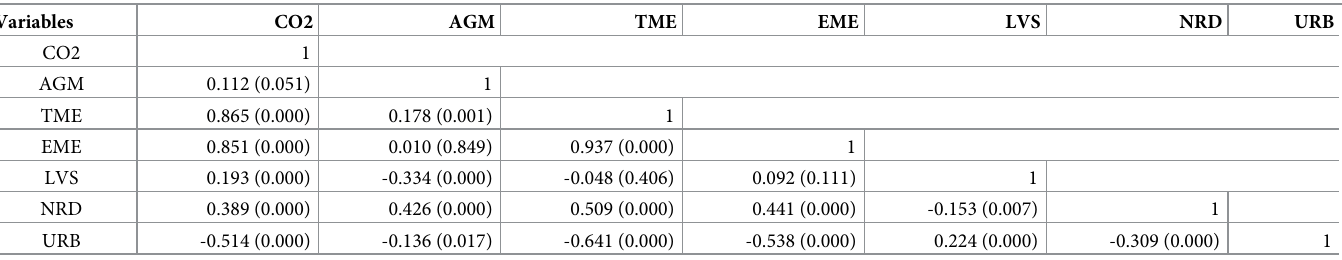
Table 3. Panel correlation matrix.